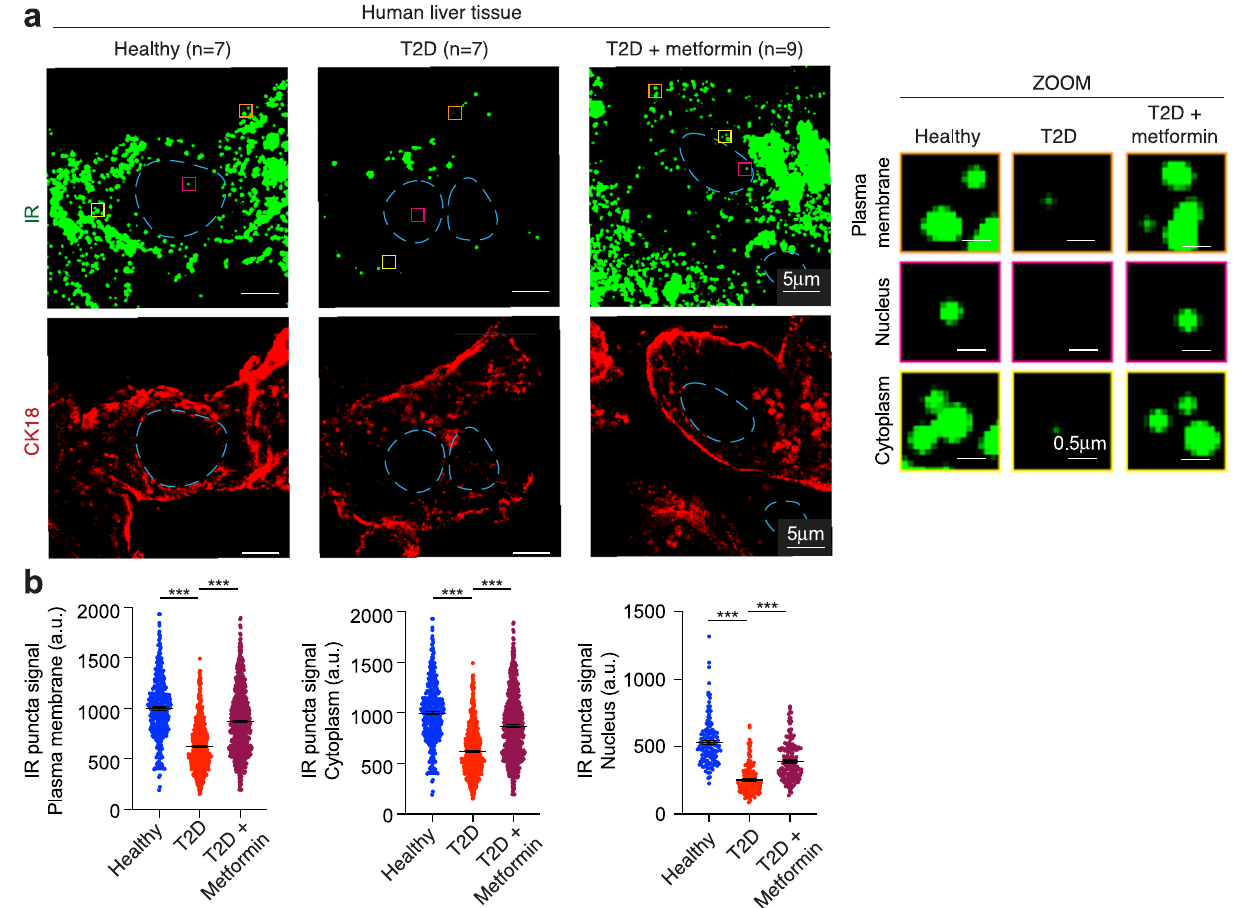
Fig. 1 | Insulin receptor bodies in human liver cells. a Representative immuno- fl uorescenceimagesforIRandCK18inlivertissuefromahealthydonor(Healthy),a donorwithT2D(T2D),andadonorwithT2Dwhohadbeentreatedwithmetformin (T2D+metformin). Dashed light blue lines represent the nuclear outline. Orange, magenta, and yellow boxes represent regions at the plasma membrane, nucleus, andcytoplasm,respectively,thataremagni fi edontheright(ZOOM).Scalebarsare indicated in the images. b Quanti fi cation of IR signal in puncta at the plasma membrane, cytoplasm, and nucleus for seven healthy donors (blue), seven donors